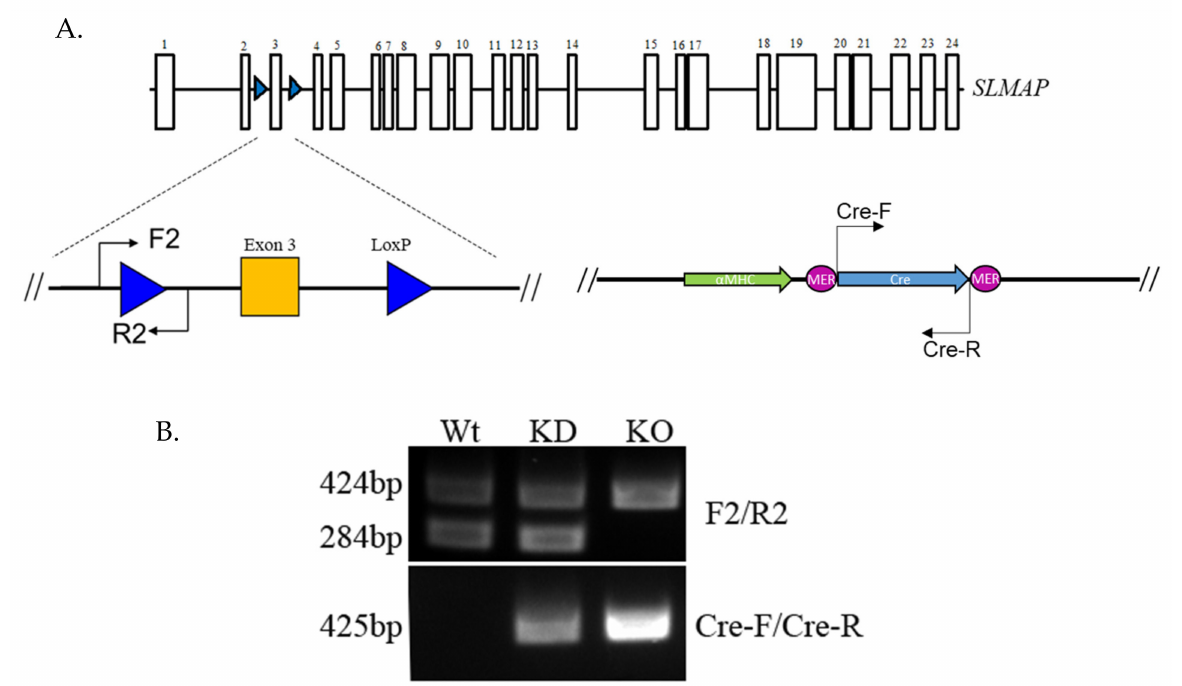
Figure 3. PCR genotyping detects floxed-SLMAP and α MHC-MerCreMer gene in mice. ( A ) Schematic representation of primers F2/R2 identifying loxP site 1 on flox-SLMAP gene and primers Cre-F/Cre-R identifying α MHC-MerCreMer gene. ( B ) PCR amplicons run on separate lanes on a 1% agarose gel labeled Wt, KD or KO identifying a wildtype, knocked-down or knockout mouse heart,